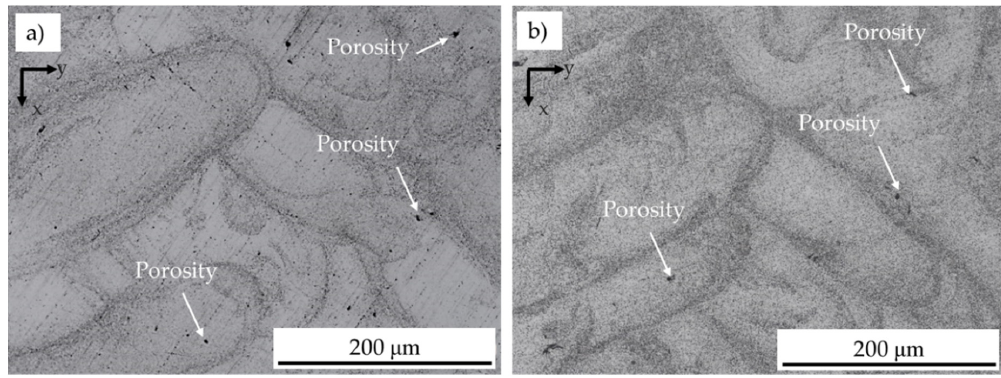
Figure 3. Micrographs of the studied alloy in ( a ) as-built and ( b ) annealed conditions.